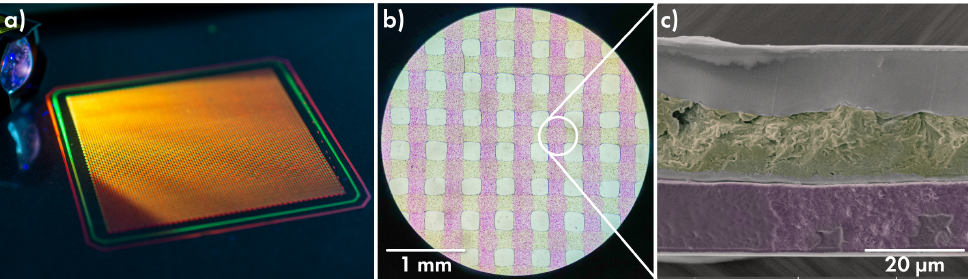
Figure 5. Large-area multilayered film under UV light ( a ), its optical image ( b ) and SEM image of cross-section ( c ).